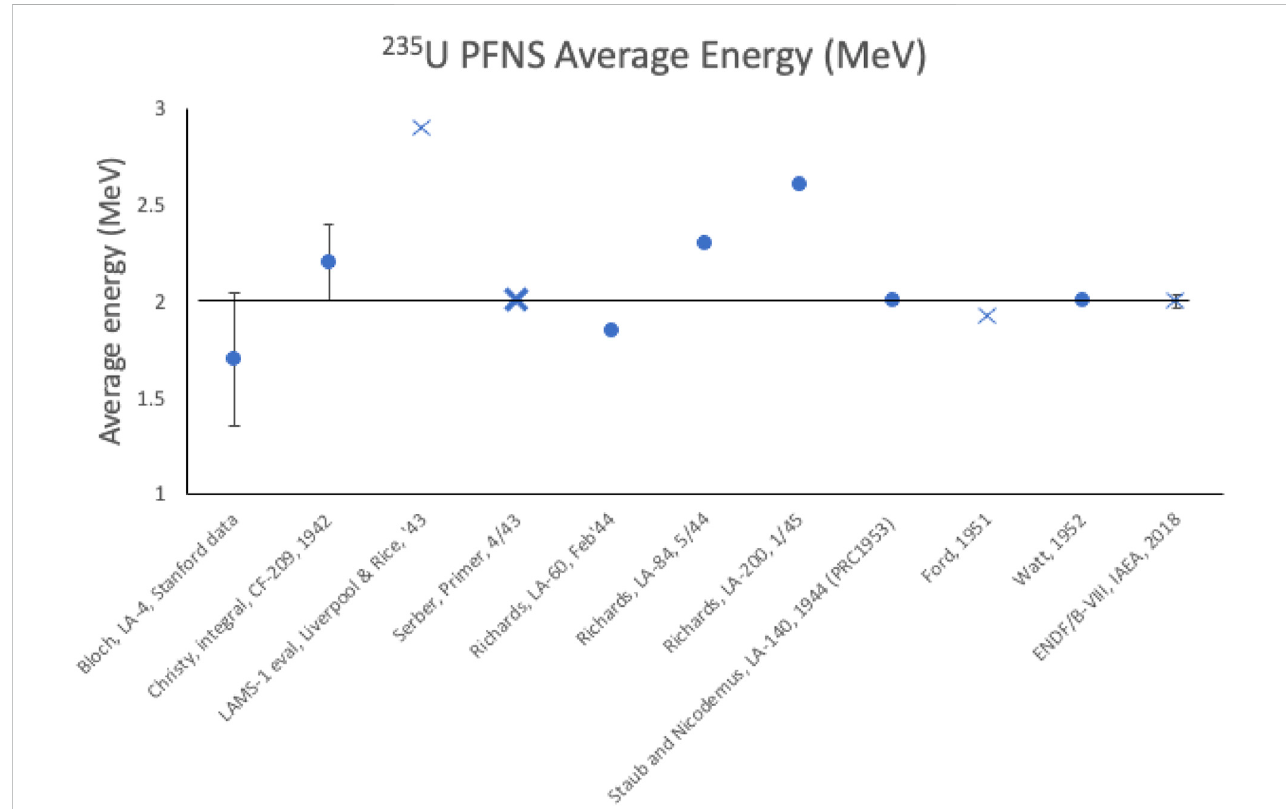
Measured 235 U PFNS average neutron energy, for experiments from 1942 – 1952; evaluated values are shown as